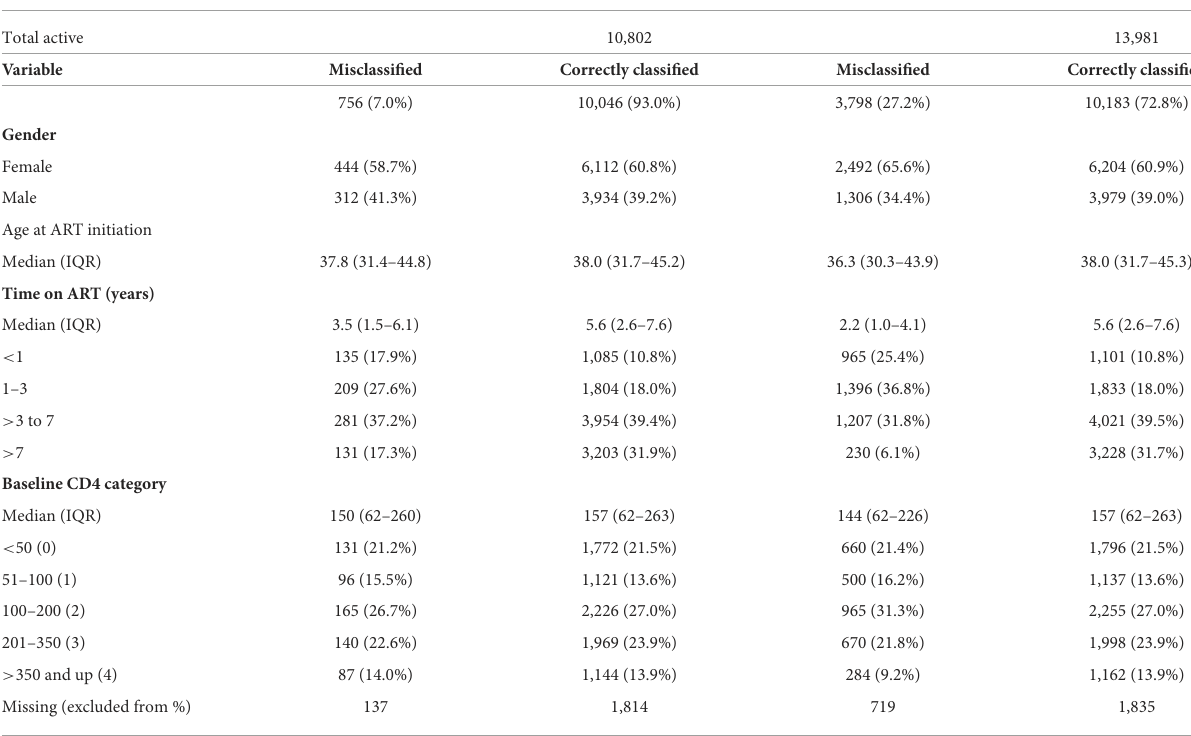
TABLE 4 Facility-level and system-wide viewpoints of correctly classified and misclassified records (2017).